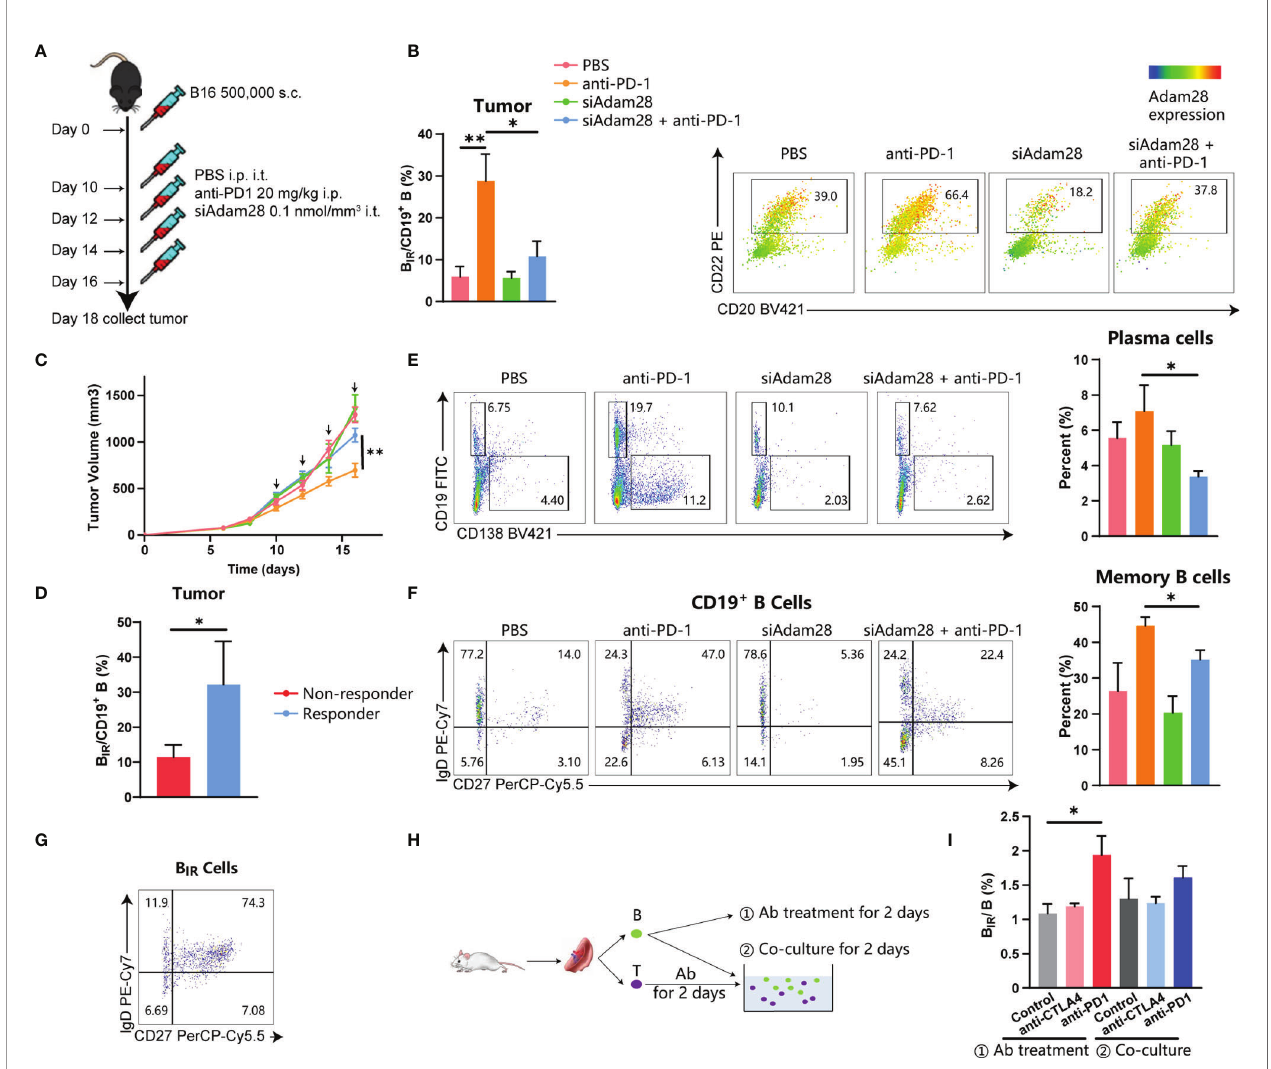
FIGURE 7 | Active role for B IR cells in ICI therapy. (A – G) C57BL6 mice were injected with 500,000 B16 tumor cells. Once tumors were palpable, mice were injected intraperitoneally (i.p.) with anti-PD1 (20 mg/kg) and/or intratumorally (i.t.) with siAdam28 (0.01 nmol/mm3) on days 10, 12,14 and 16.Tumors were collected on day24 after tumor inoculation and processed as described in Methods (A) . Each group was marked by a different color (B. C, F) and the mean tumor volume of the tumor- bearing mice was measured (C) , n=6 mice/group (only 12 mice for the anti-PD1 group). Data are presented as mean values ±SEM. (B) Flow cytometry analysis of CD20+CD22+Adam28+ B IR cells in tumor tissues. The heatmap shows a projection of Adam28 expression onto all tumor CD45+CD19+ B cells and the histogram shows the percentage of B IR cells in all CD19+ B cells. (D) Percentage of B IR cells in all CD19+ B cells in tumor tissues were compared between mice that respond (n=S) or not respond (n=7) to ICI therapy. (E) Determination (left) and quanti fi cation (right) of plasma cells (CD19-CD138+) in CD45+ immune cells of tumor tissues. Determination of memory subsets of CD19+ B cells (F) and B IR cells (G) i n tumor tissues. (H, I) B cells and T cells were separated from the spleen of the mouse. CD B cells were directly treated with anti-PD1 (20g/m)lor anti-CTLA4 antibodies (201-Jg/ml);@ T cells were pretreated with these antibodies and then co-cultured with B cells.The percent of B IR cells in all B cells was quanti fi ed (I) .Data are mean values ±SEM, and individual data points are shown. *P < 0.05; **P <